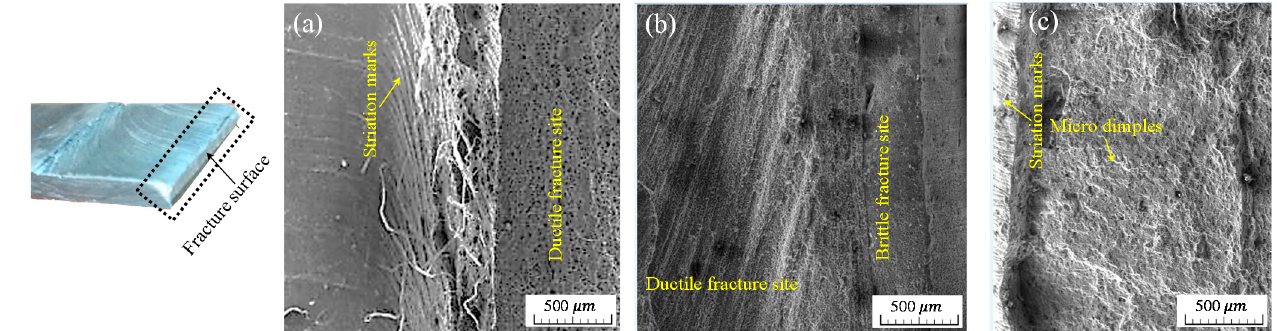
Figure 16. SEM images of fracture surface: ( a ) as-welded FSW samples; ( b , c ) in situ rolled FSW samples.